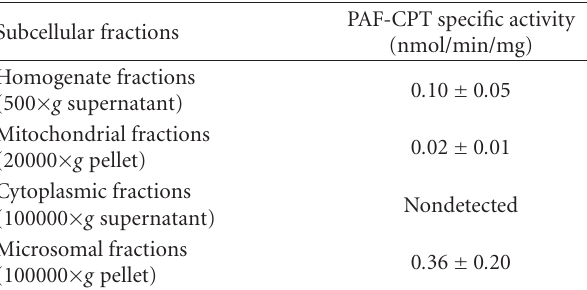
Table 1: Subcellular specific activity of PAF-CPT from human mesangial cell preparations ( n =